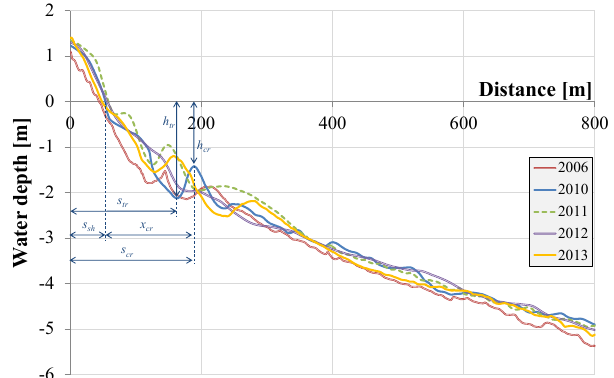
Figure 2. Example of cross-shore evolution (profile 13) during the investigated years. Bar characteristics referring to the 2010 profile are also reported.